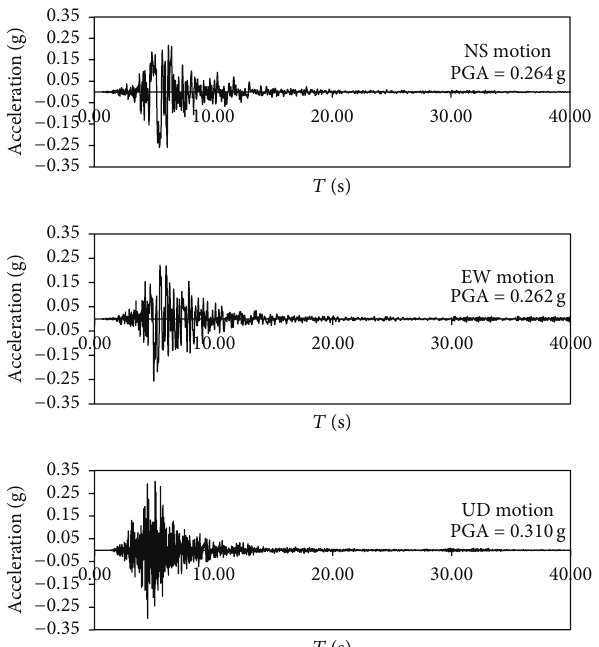
Figure2:RecordingsatMirandolaStation(MRN):NS,EW,andUD